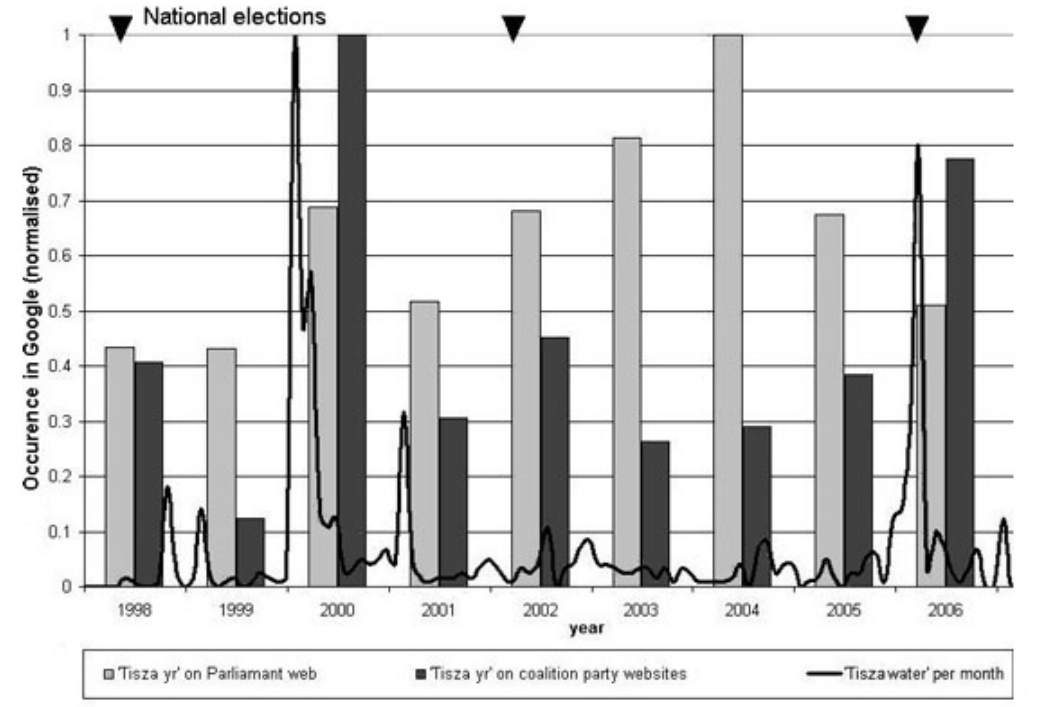
Fig. 3 . Windows of opportunity illustrated by the normalized number of occurrences of specified terms arising from online search using Google. Note: The incorporation of Internet-based figures comes with the recognition that the medium has become increasingly used by political parties and that the number of issues covered on their websites and the number of pages itself have increased. Thus the figure should be read only as an indication of the changing attention of party websites to the Tisza and not as an absolute assessment of the political agenda of the